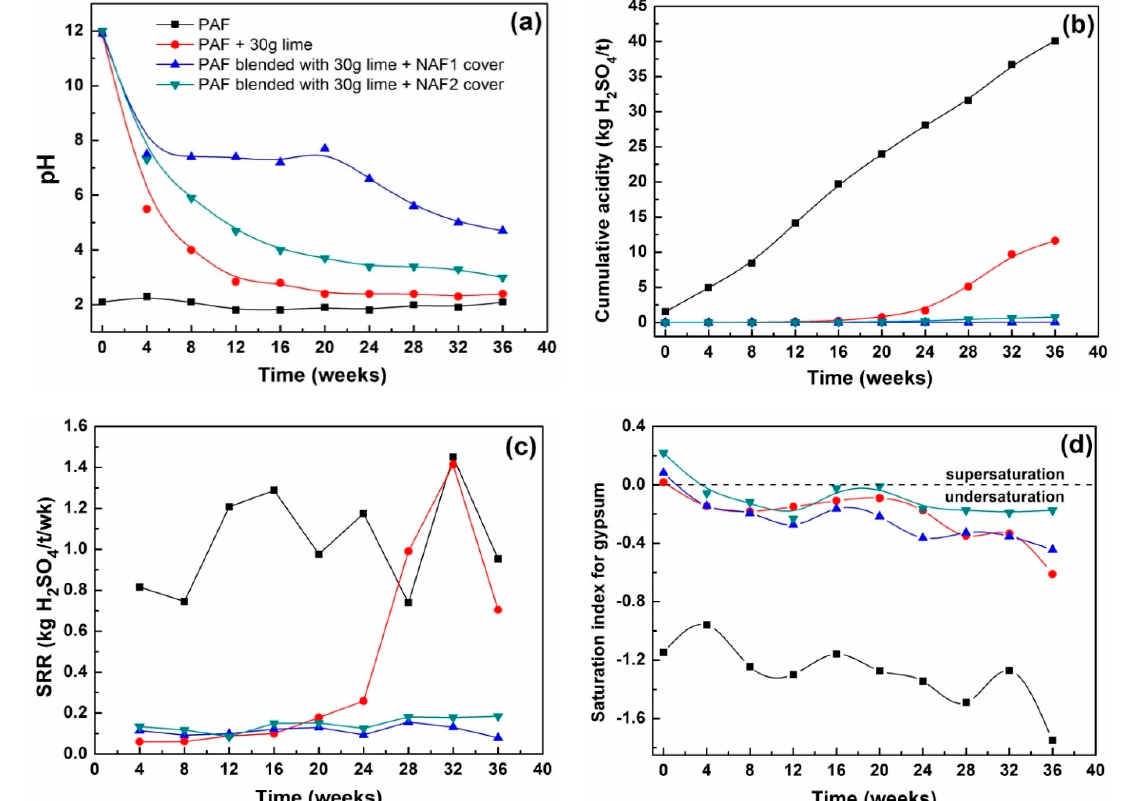
Figure 4. Leachate chemistry ( a ) pH; ( b ) cumulative acidity; ( c ) sulphate release rate; and ( d ) gypsum saturation index from natural waste KLC tests. Cumulative acidity and SSR are normalised to per tonne of PAF. Figure legend for (a) is common to (b–d).